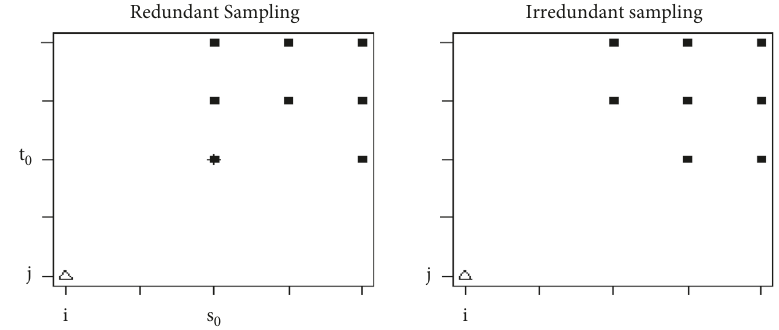
Figure 3: Two schemes for redundant sampling and unredundant sampling with eight